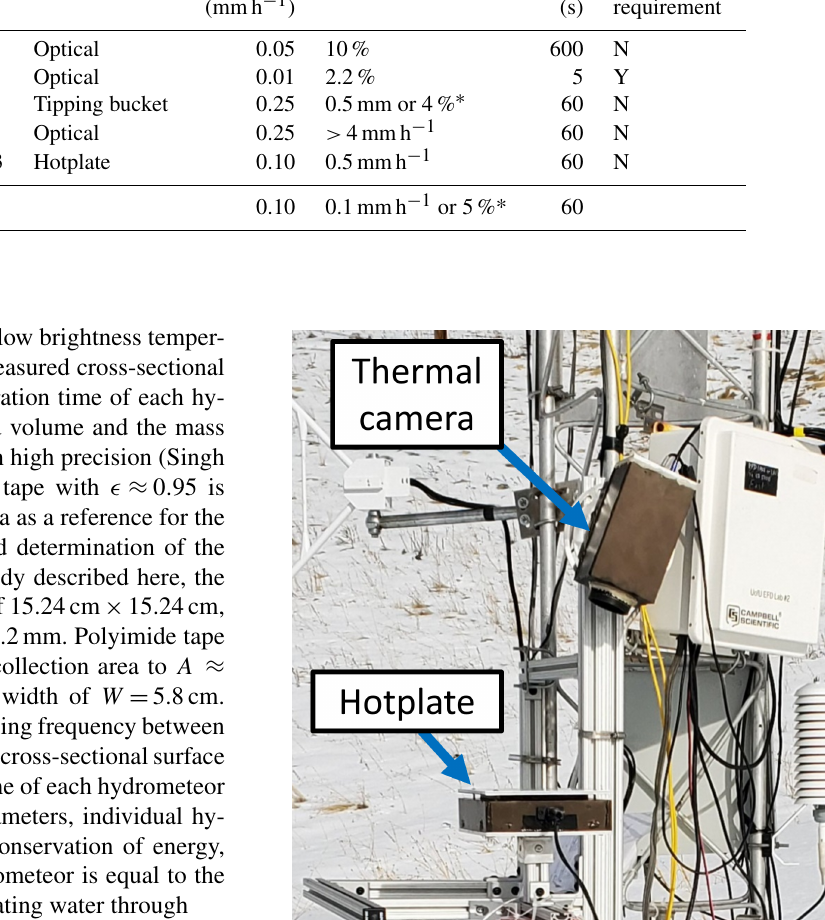
Table 1. Precipitation measurement instrument specifications. Model